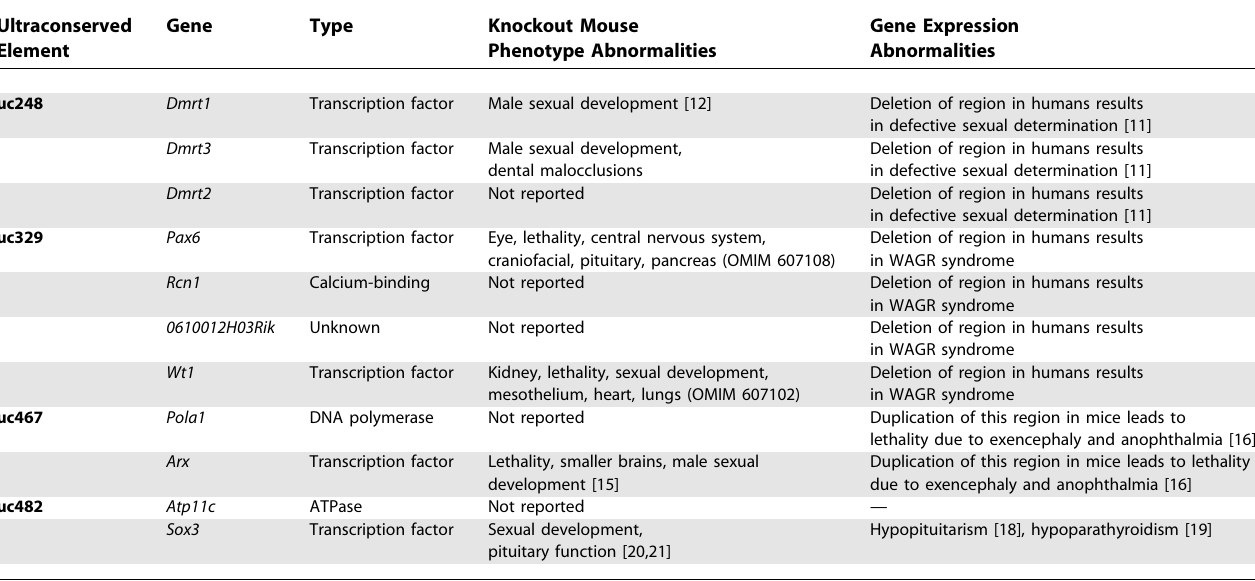
Table 1. Mouse Knockout and Gene Expression Phenotypes for Genes Adjacent to the Deleted Ultraconserved Elements Ultraconserved Element